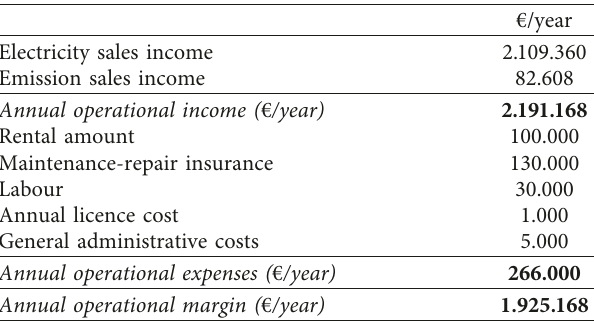
Table 7: Annual income-expense table